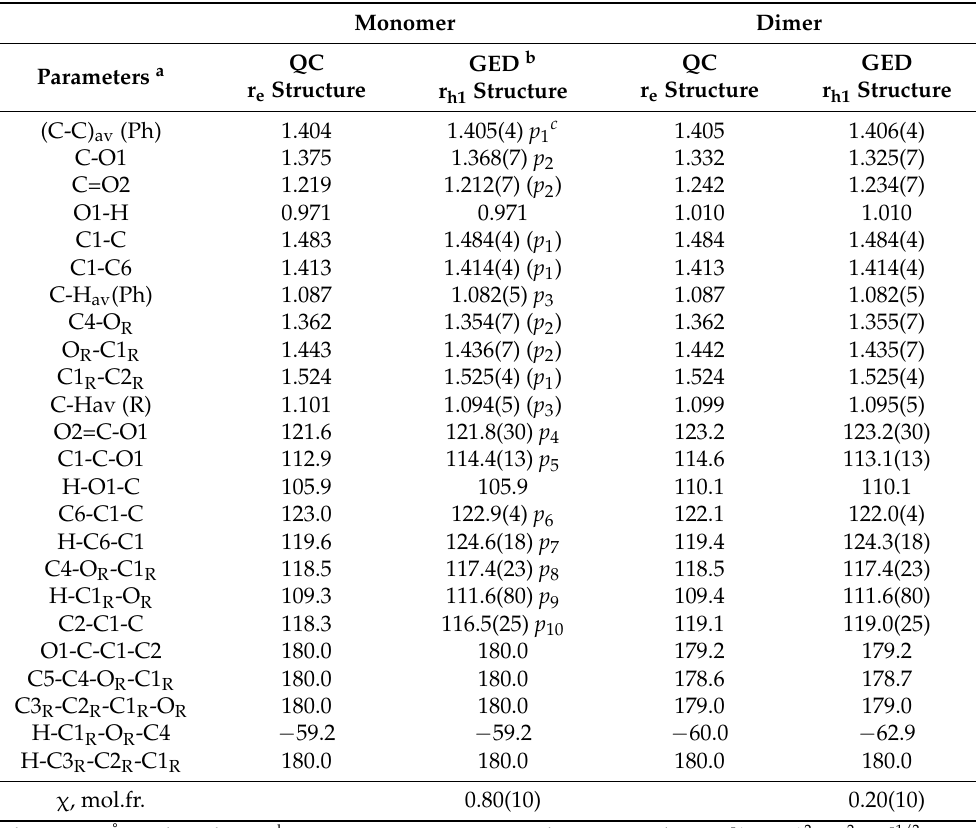
Table 1. Theoretical (B97D/6-311++G **) and experimental (GED) geometric parameters of the gaseous monomer and cyclic dimer POBA (R f =